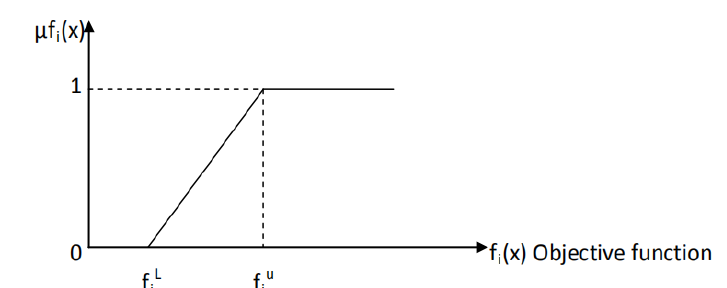
Fig. 1. Membership function of maximization-type objective